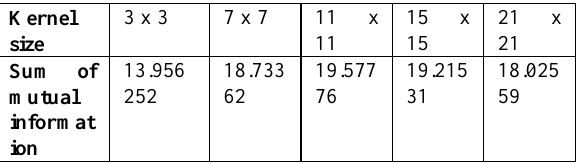
Figure 3. Textural feature maps of various GLCM measures obtained using kernel size of 11 x 11.